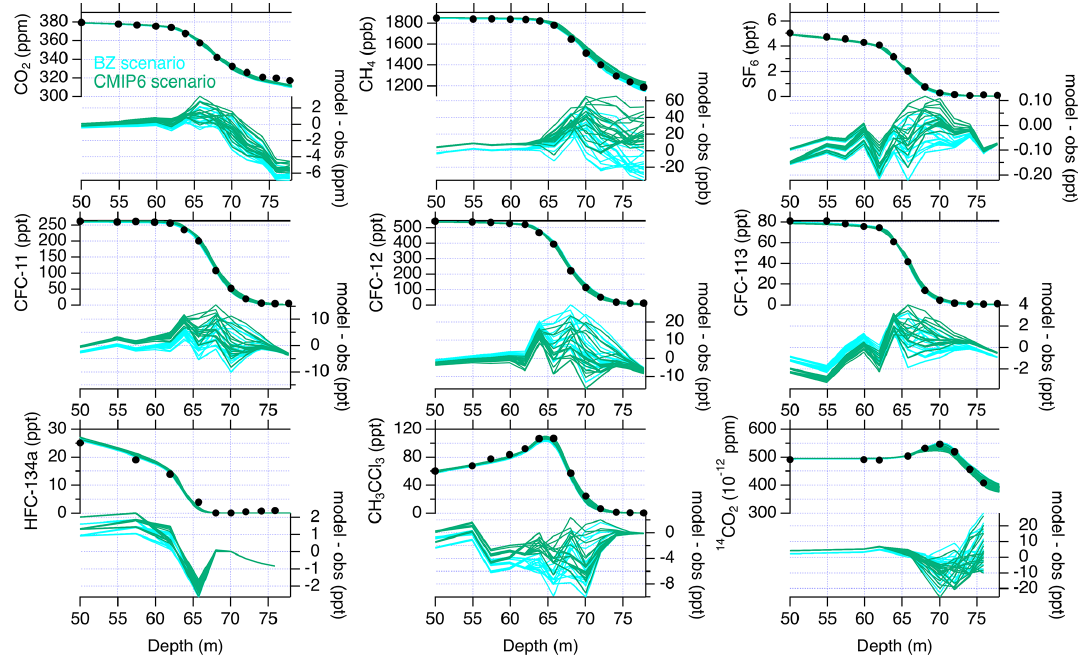
Figure 9. Same as Fig. 7 but for the NEEM firn. Only the simulation results with RMSD values of < 1.0 are